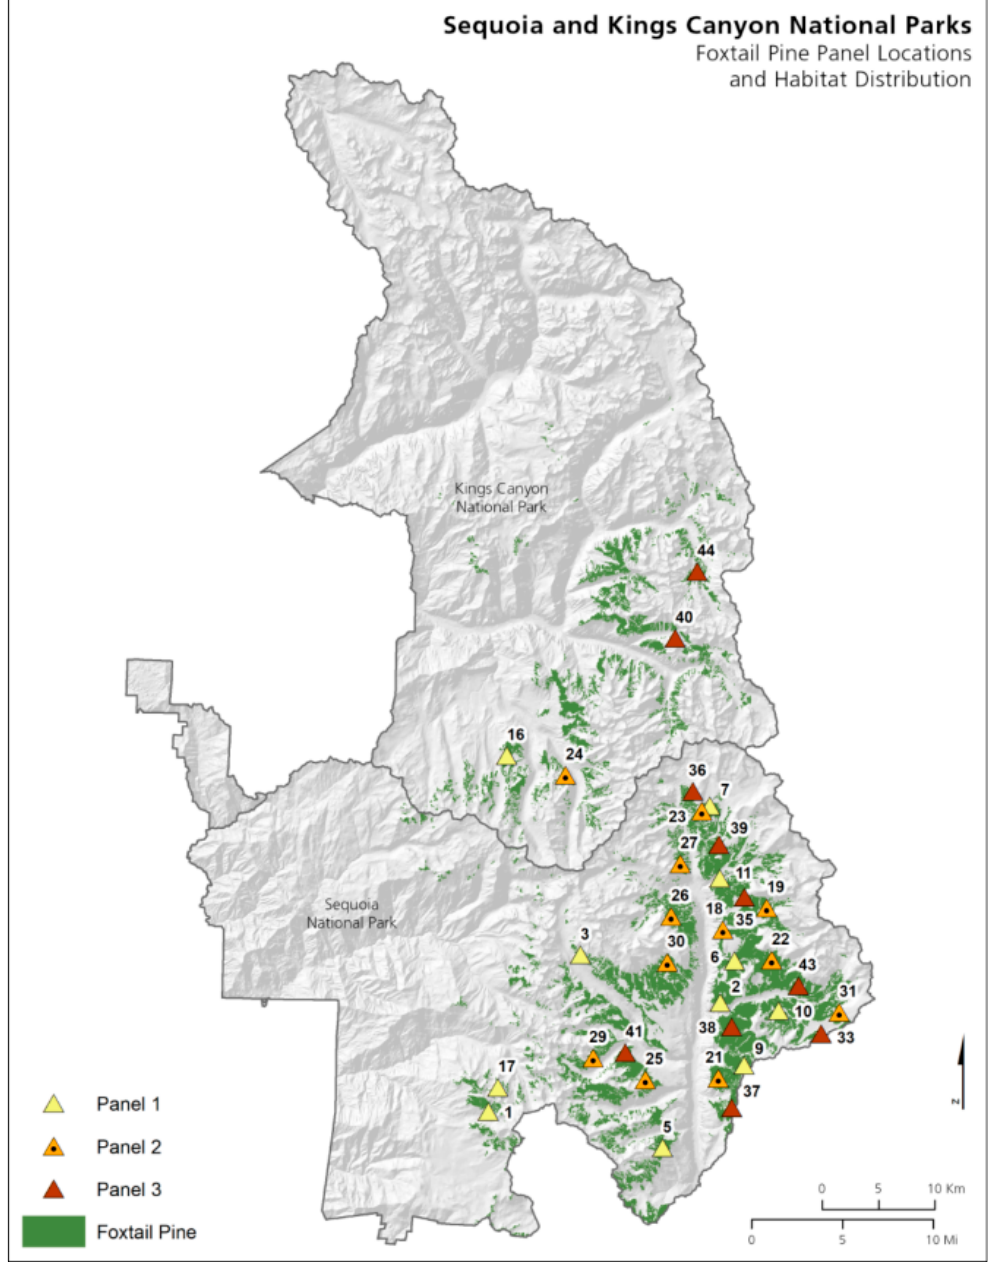
Figure 6. Foxtail pine distribution and plot locations in Sequoia and Kings Canyon National Parks, CA, USA. Plots are assigned to one of three panels (12 plots each) and are sampled using a rotating re-visit design. Thirty-three of the planned 36 plots had been installed at time of publication.